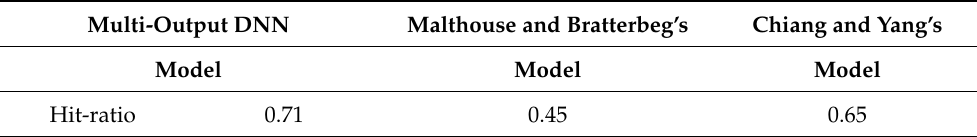
Table 6. Hit-ratios (top 20%) for multi-output model, Malthouse and Blattberg’s study [24], and Chian and Yang’s study